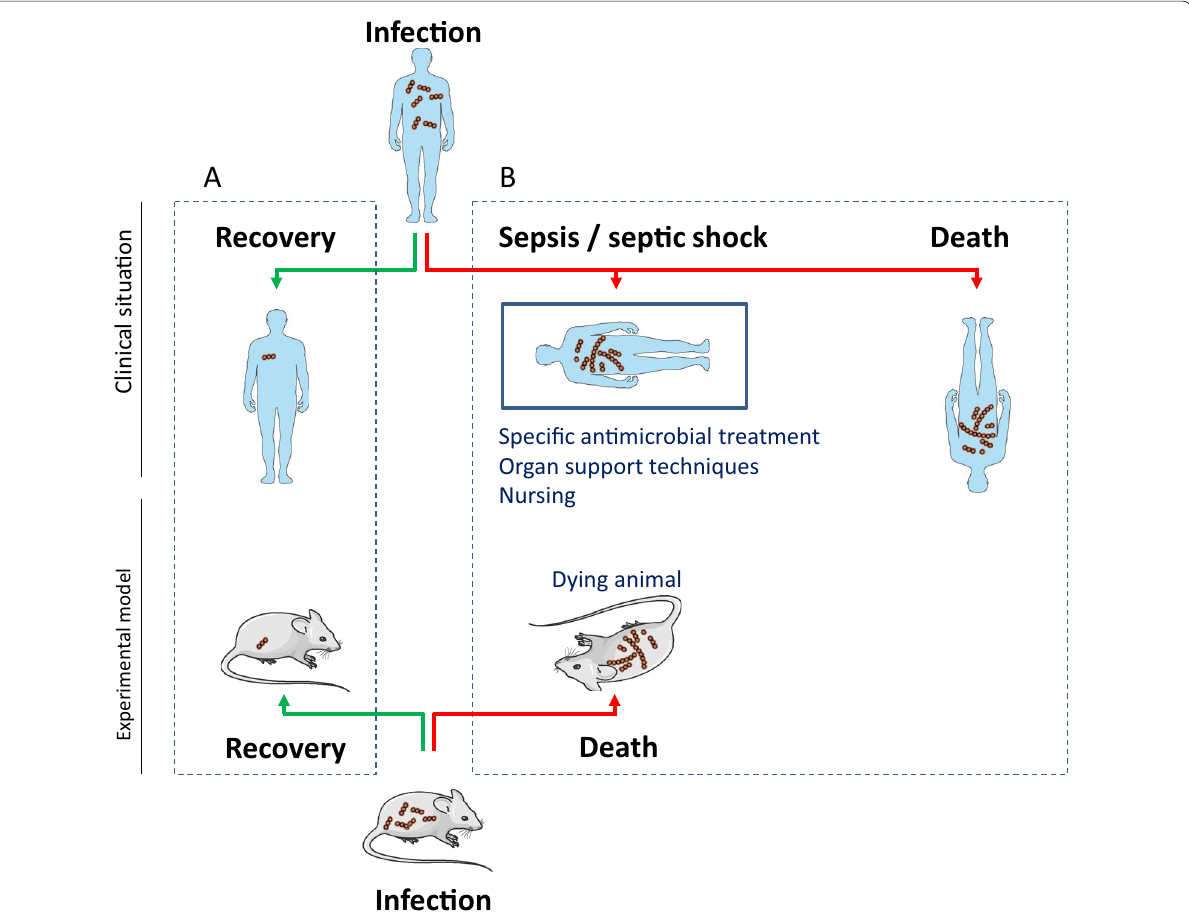
Fig. 2 Limits of classical animal models regarding sepsis/septic shock. a Infected animals are powerful models for basic laboratory observations and/or mechanistic studies of host/pathogen interactions. b Animals with a severe infection have two options, curing or dying, while human has an “intermediate” possibility, surviving. ICU patients represent an abnormal situation to an evolutionary view that is difficult to replicate. Infected animals with lethal dose of microbial agents are killed at a defined time point and compared with septic ICU patients. The ICU environment (monitoring, nursing) and treatments (specific antimicrobial treatment, organ support technics) are rarely reproduced in the animal models leading to an uncontrolled mismatch between animal models and “real life” of human